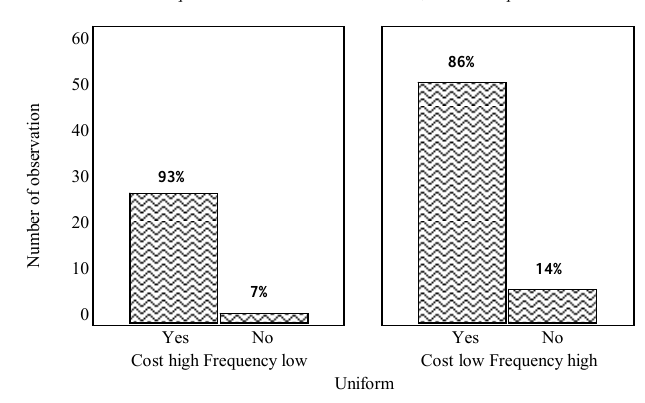
Cost low Frequency highCost high Frequency low Product characteristic high cost, low frequency/low cost, high frequency and uniform/non- uniform brand transmutation Product characteristic high potential for differentiation/low potential for differentiation and uniform/non-uniform brand product characteristic (high potential for differentiation/low potential for differentiation) of a product or service on the Internet and the transmutation